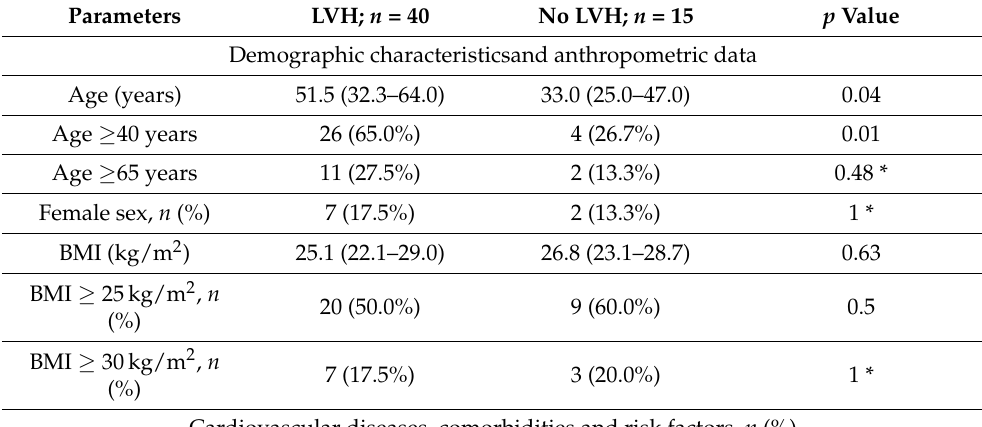
Table 1. Characteristics of the patients with and without left ventricular hypertrophy based on left ventricular mass indexed by body surface